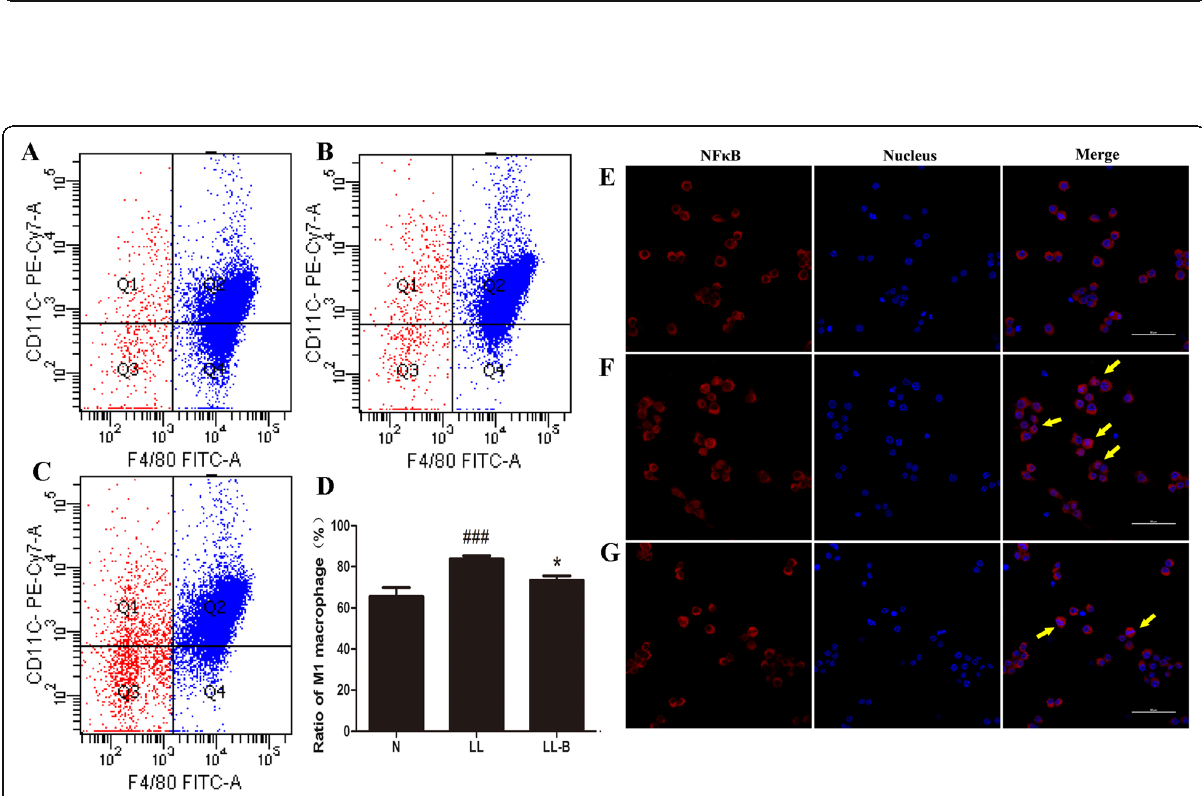
Fig. 6 Effects of BBR on LPS-induced IL-6 ( a - b ), iNOS ( c - d ) and MIP1 ( e ) expressions in Raw264.7 cells. N, normal control group; LL, low LPS group; LL-B, low LPS + BBR group; LL-M, low LPS + Metformin group; LH, high LPS group; LH-B, high LPS + BBR group; LH-M, high LPS + Metformin group. Compared with N group, ## P < 0.01, ### P < 0.001; Compared with LL or LH group, * P < 0.05, ** P < 0.01, *** P < 0.001